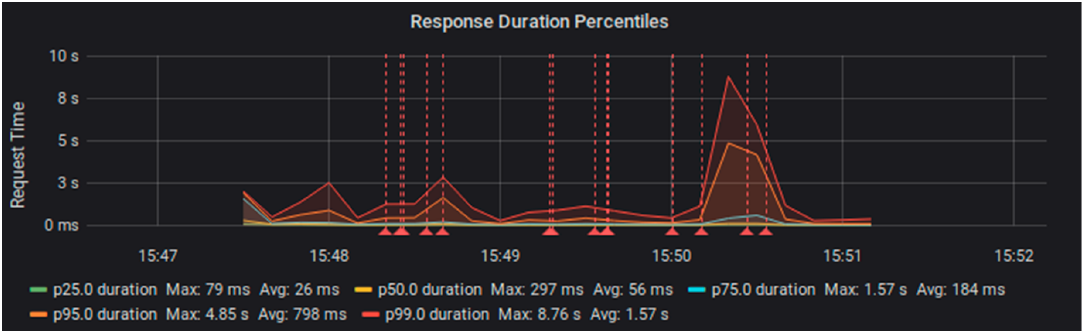
Figure 10. Trellis Cassandra shows error responses with 28 test workers.